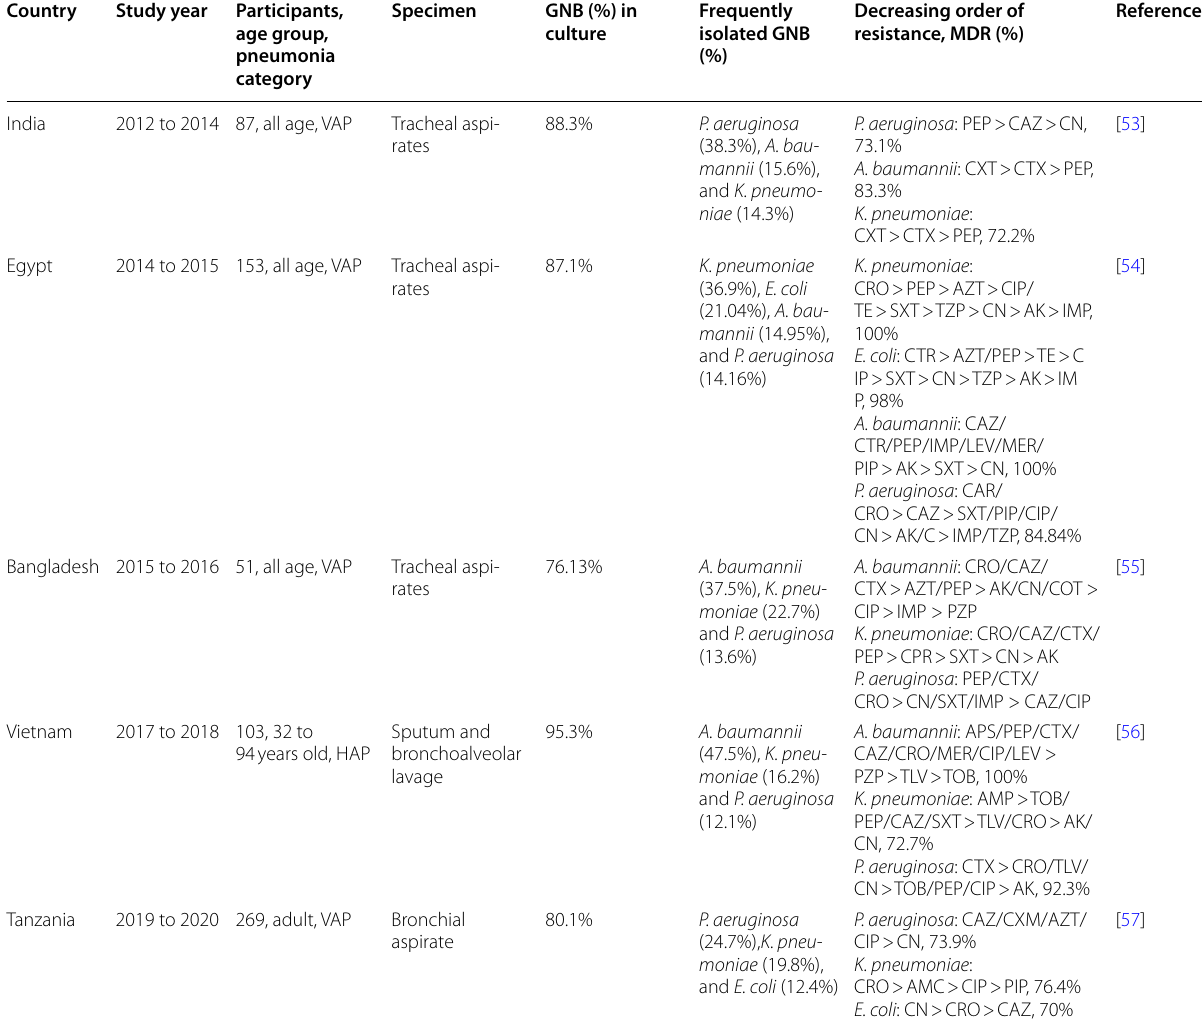
Table 2 Summary of the isolation and drug resistance profile of GNB in